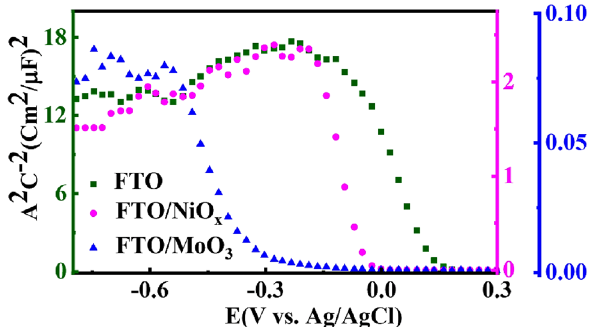
Figure 6. Mott–Schottky plot of CISe films deposited on different substrates measured in 0.5 M Na 2 SO 4 solution.